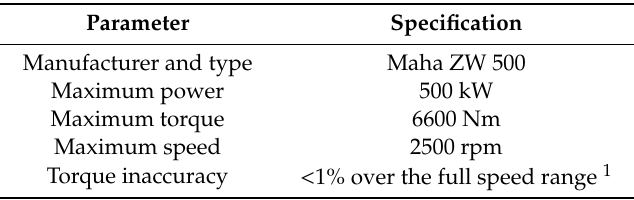
Table 4. Dynamometer